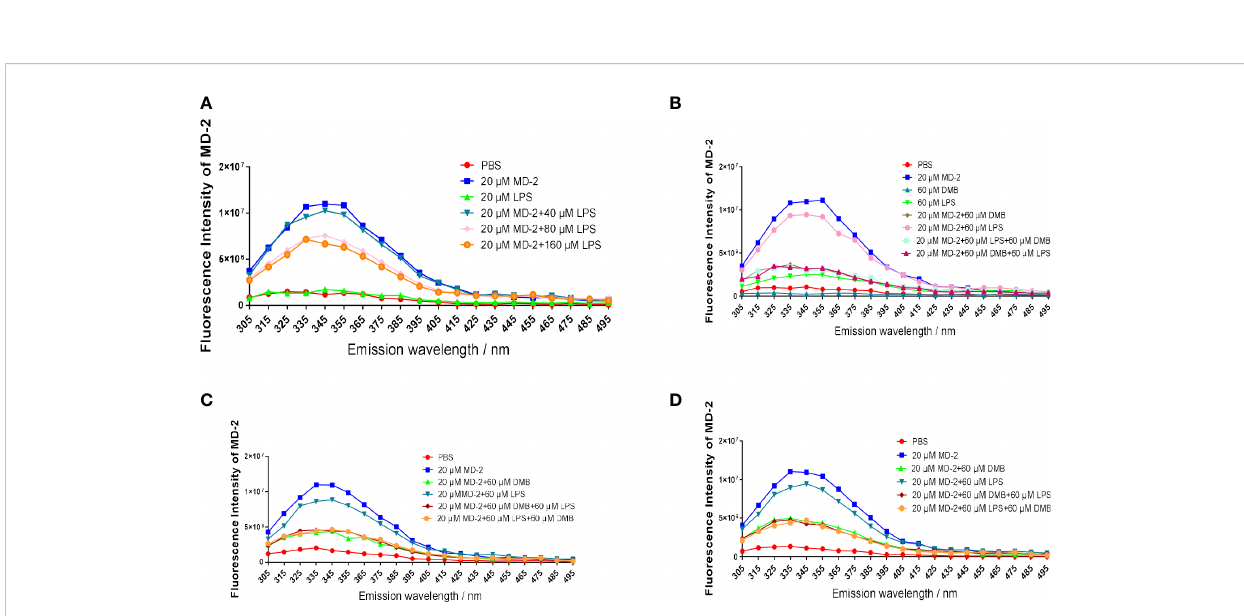
FIGURE 7 DMB competitively inhibited LPS binding to the MD-2 protein. (A) The fl uorescence emission spectrum of the MD-2 protein co-incubated with LPS after excitation at 280 nm. (B) The fl uorescence emission spectrum of the MD-2 protein co-incubated with LPS or DMB for 15 min, and then DMB or LPS was added for 5 min. (C) The fl uorescence emission spectrum of the MD-2 protein co-incubated with LPS or DMB for 60 min, and then DMB or LPS was added for 5 min. (D) The fl uorescence emission spectrum of the MD-2 protein co-incubated with LPS or DMB for 30 min, and then DMB or LPS was added for 30 min. n =